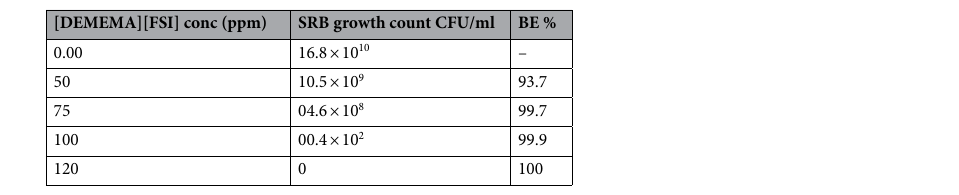
Table 4. Total SRB count and biocidal efficiency BE % of [DEMEMA][FSI].